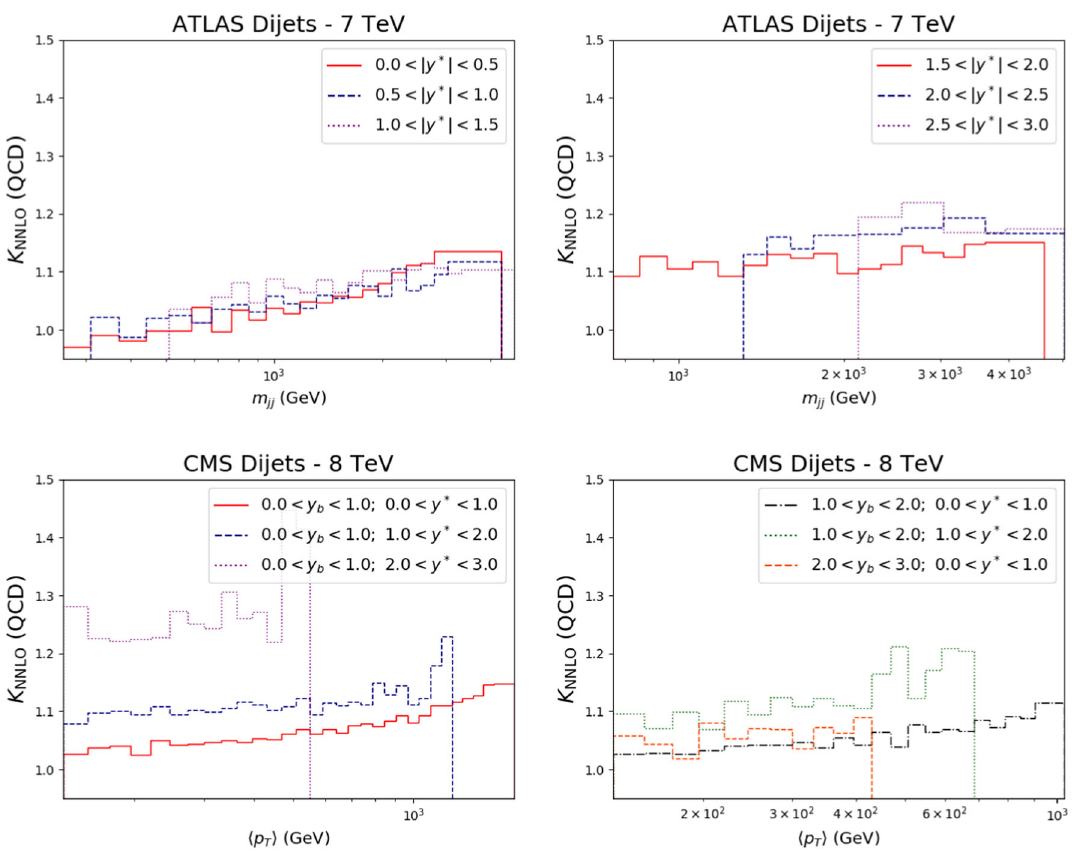
Fig. 2 The NNLO QCD K -factors, Eq. (3.2), corresponding to the ATLAS 7 TeV (top) and CMS 8 TeV (bottom) dijet cross-sections evaluated with NNPDF3.1 PDF and scale μ = m jj . Results are shown as function of the jet p T in different jet rapidity bins, with the most central (forward) bins in the left (right)